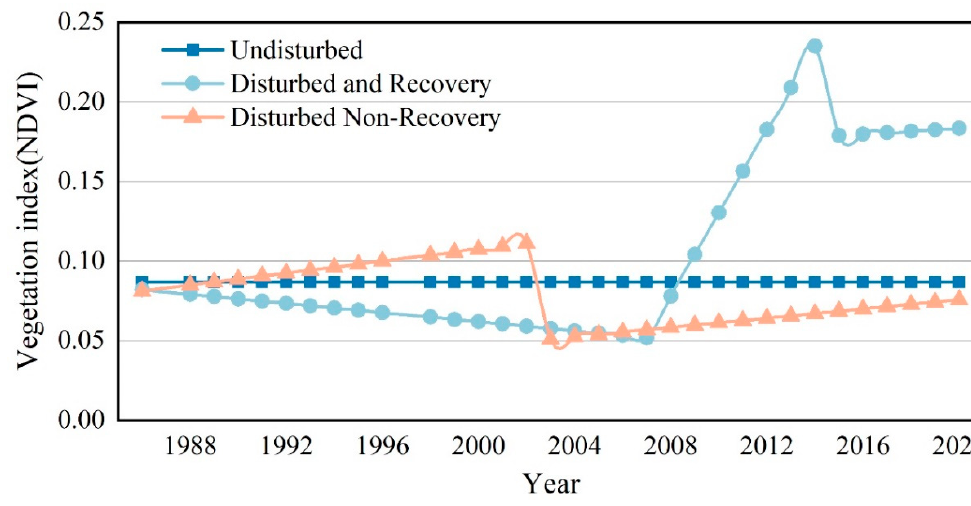
Figure 3. Three patterns of pixel-based disturbance and recovery.